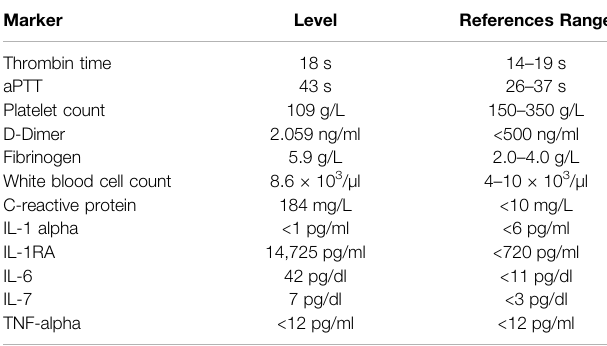
( Figure 2 ). Blood tests with hemoglobin electrophoresis con fi rmed the presence of heterozygous hemoglobin S